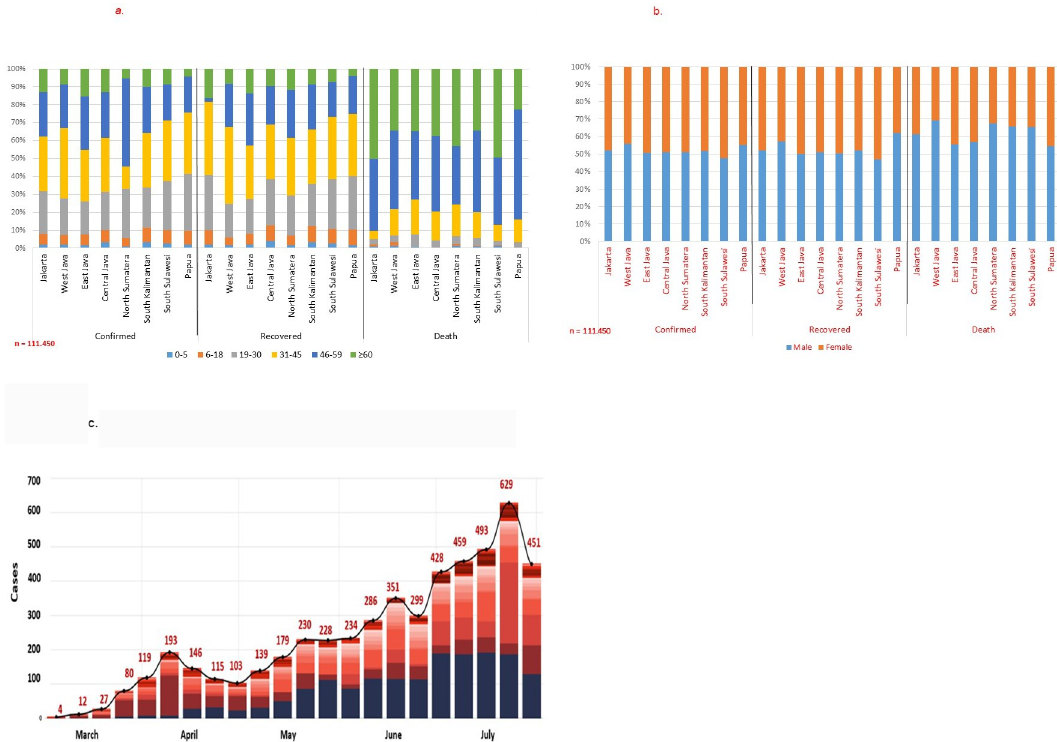
Fig 1. a. Classification of status according to age group in 8 priority provinces in Indonesia from March 2 nd –August 2 nd 2020. b. Classification of patients’ status according to sex in 8 priority provinces in Indonesia from March 2 nd –August 2 nd 2020. c. Incidence of death cases by week due to COVID-19 in Indonesia from March 2 nd –August 2 nd 2020.